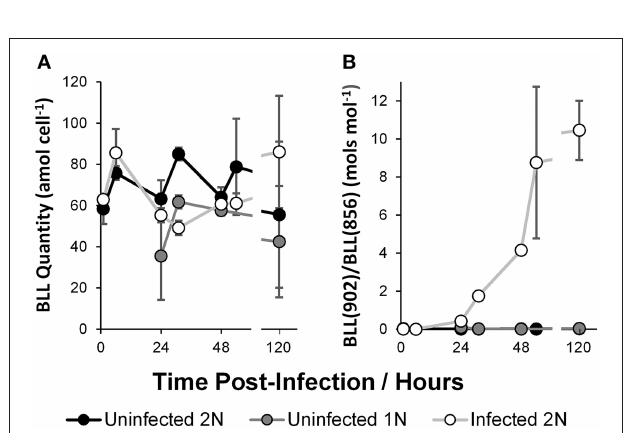
FIGURE 3 | Betaine-Like Lipid (BLL), total quantity per cell (A), and ratio of BLL(902; 22:6/22:6) quantity to BLL(856; 18:1/22:6) quantity (B). Data represent the mean average of two biological replicates with error bars of one standard deviation. See Supplementary Table 1 for tabulated